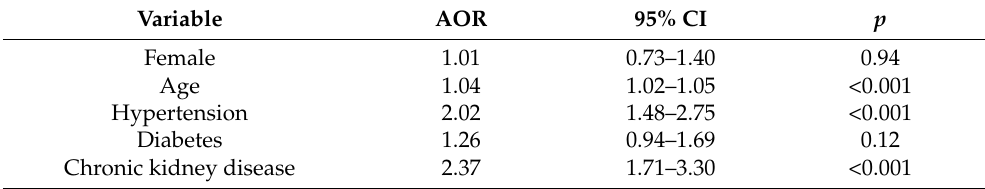
Table 3. Multivariate regression model of independent association with AKI.